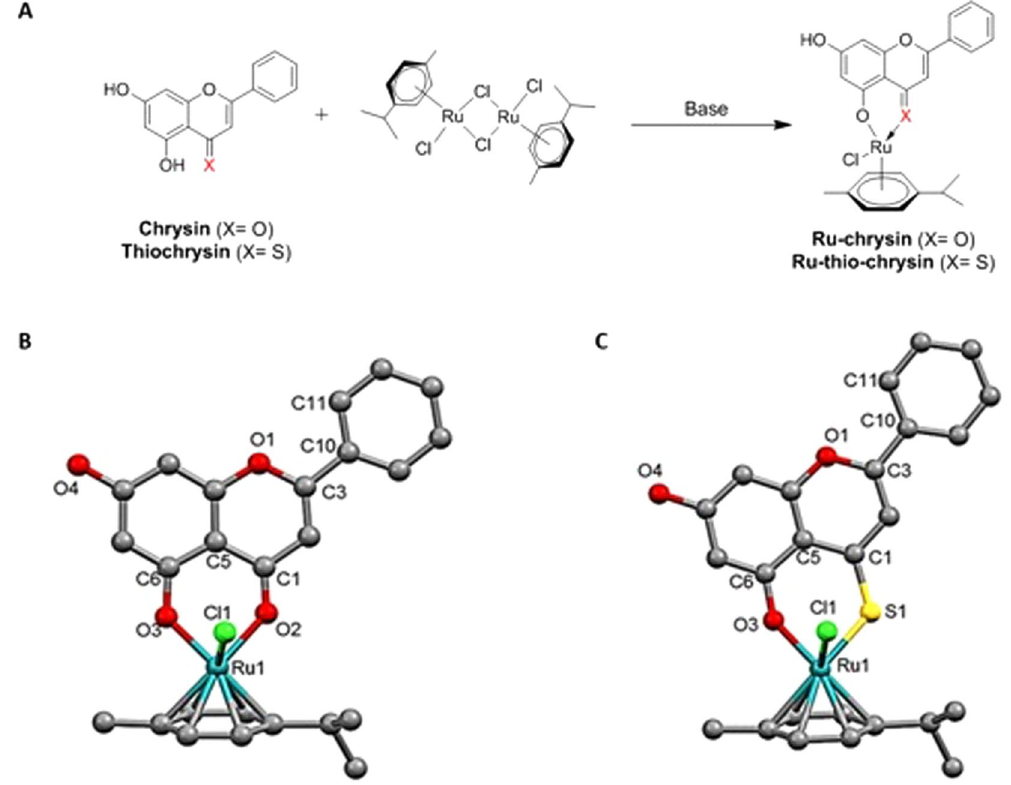
Figure 1. Synthesis scheme and molecular structures for Ru-chrysin and Ru-thio-chrysin. ( A ) Schematic diagram represents the synthesis of Ru-chrysin and Ru-thio-chrysin from chrysin and thio-chrysin, respectively via reaction with bis [dichlorido ( η 6 - p -cymene)] ruthenium(II). The molecular structures of Ru-chrysin ( B ) and Ru-thio-chrysin ( C ) were determined by X-ray diffraction studies. The hydrogen bonds are not shown in the figures to enhance the clarity of the molecular images. The symbols C, O, Cl, S and Ru represent carbon, oxygen, chlorine, sulfur and ruthenium, respectively. The numbers shown indicate the position of respective carbon